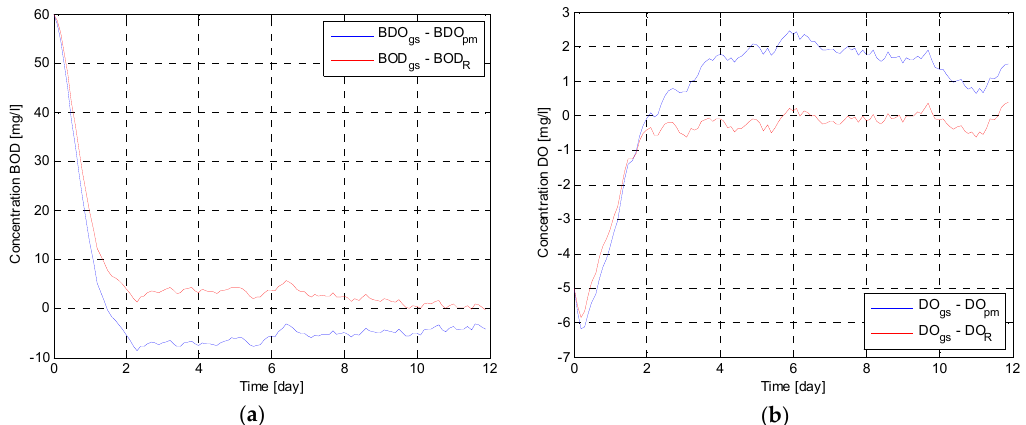
Figure 6. Distribution of errors of BOD ( a ) and DO ( b ) signals resulting from inaccurately selected model parameters (the same extortions).